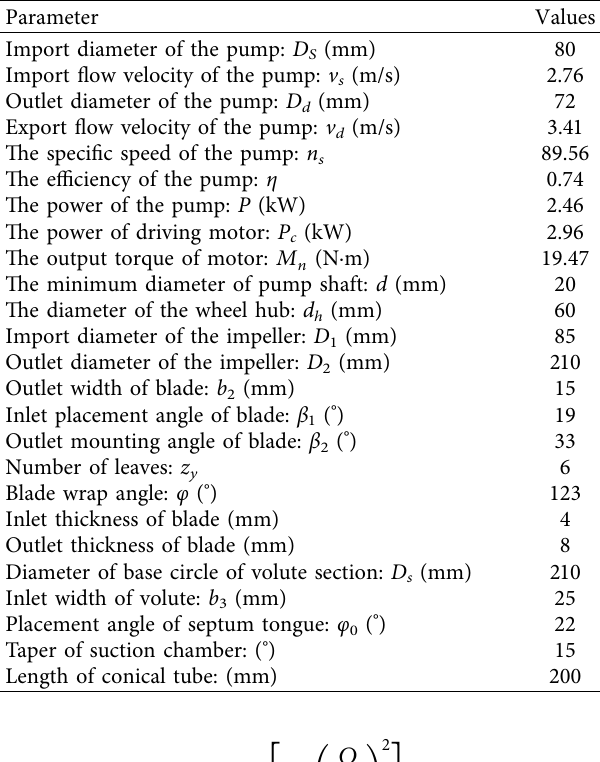
Table 2: Each plastic centrifugal pump structure